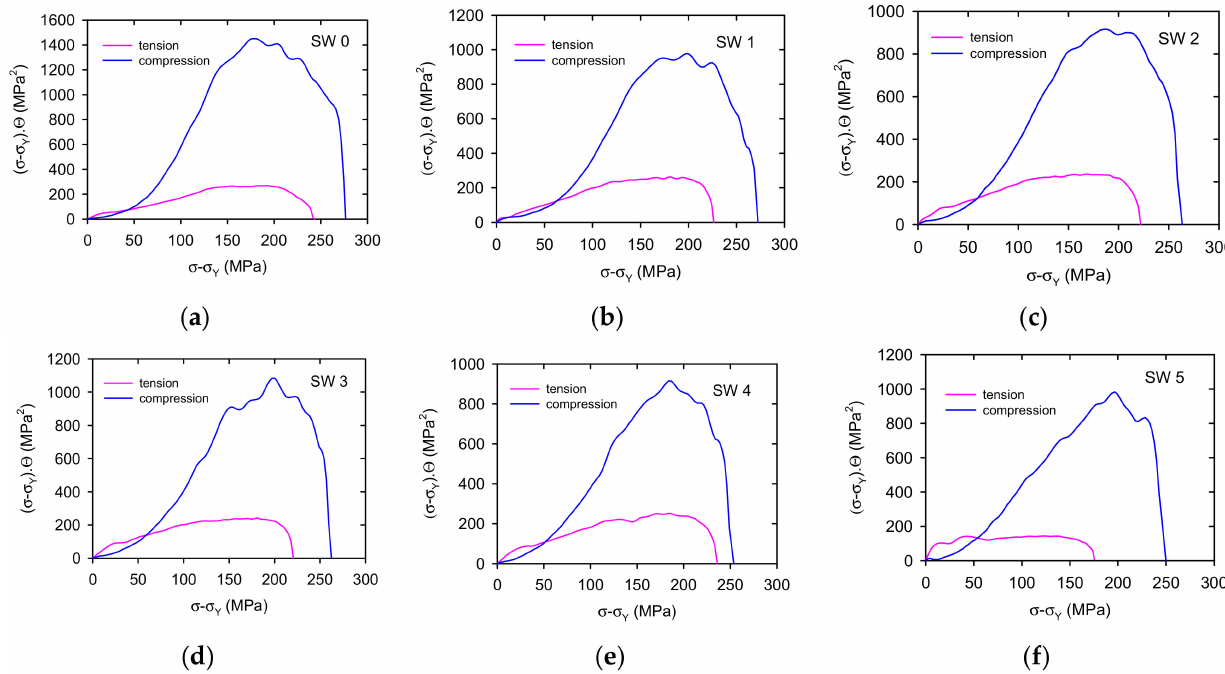
Figure 9. ( σ − σ Y ). Θ vs. ( σ − σ Y ) plots constructed for curves estimated in tension and compression for ( a ) SW0, ( b ) SW1, ( c ) SW2, ( d ) SW3, ( e ) SW4, ( f )